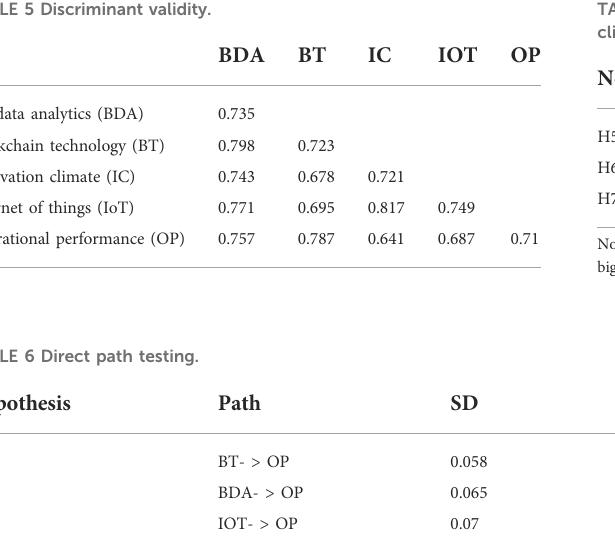
TABLE 5 Discriminant validity.